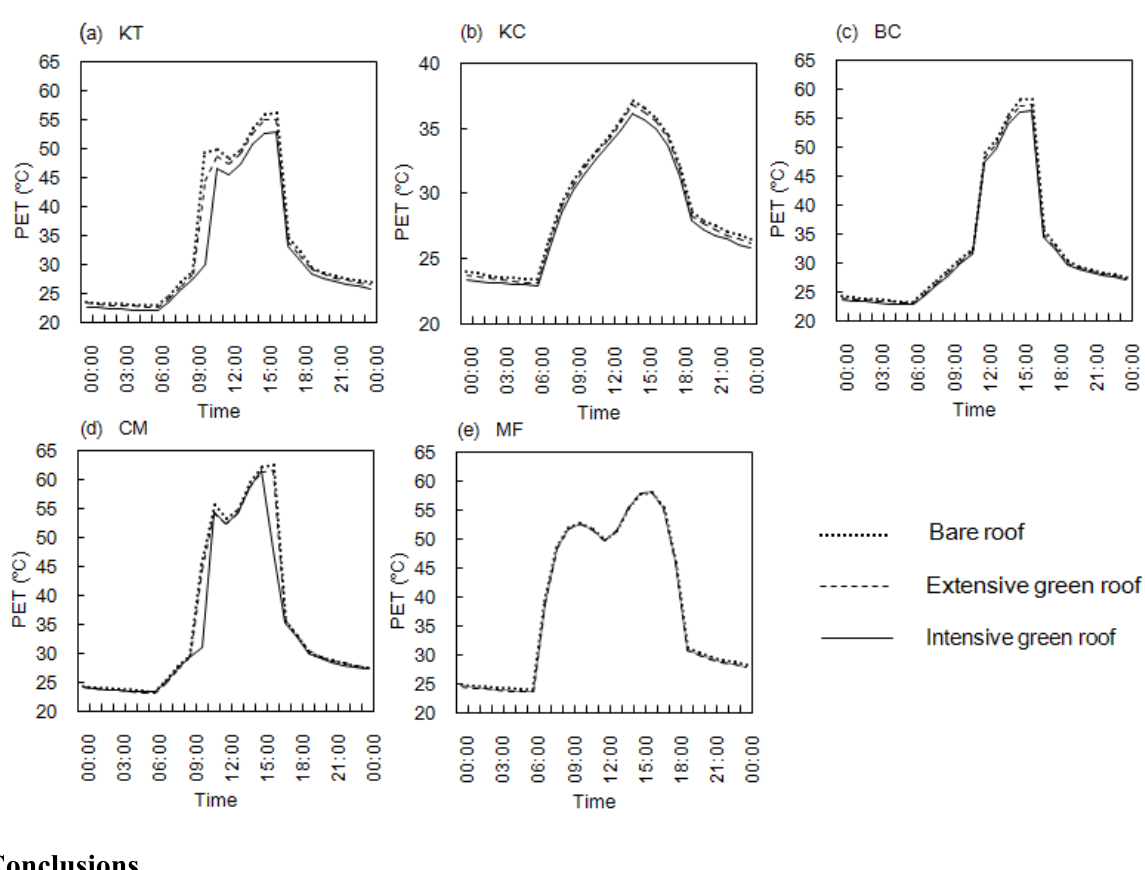
Figure 12. Diurnal PET circle under the three scenarios of bare roof, EGR and IGR at the pedestrian